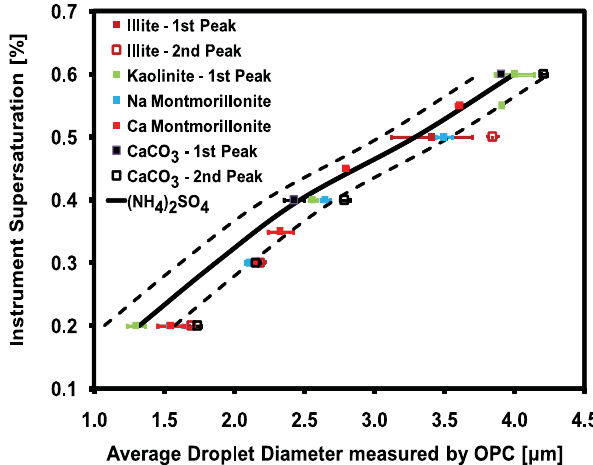
Fig. 5. Activated droplet sizes of wet generated mineral dust CCN with s c equal to the instrument supersaturation. Error bars represent variability in droplet sizes as measured by the OPC at same instru- ment supersaturation. Dashed lines represent ± 0.25µm variability in (NH 4 ) 2 SO 4 droplet sizes.